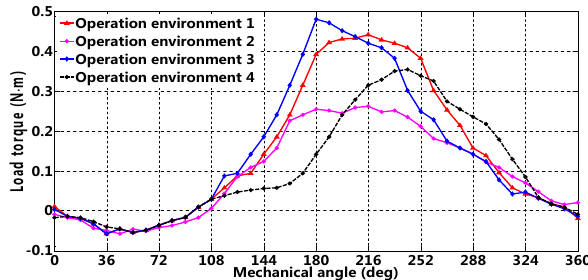
Figure 2. Load torque under different operation